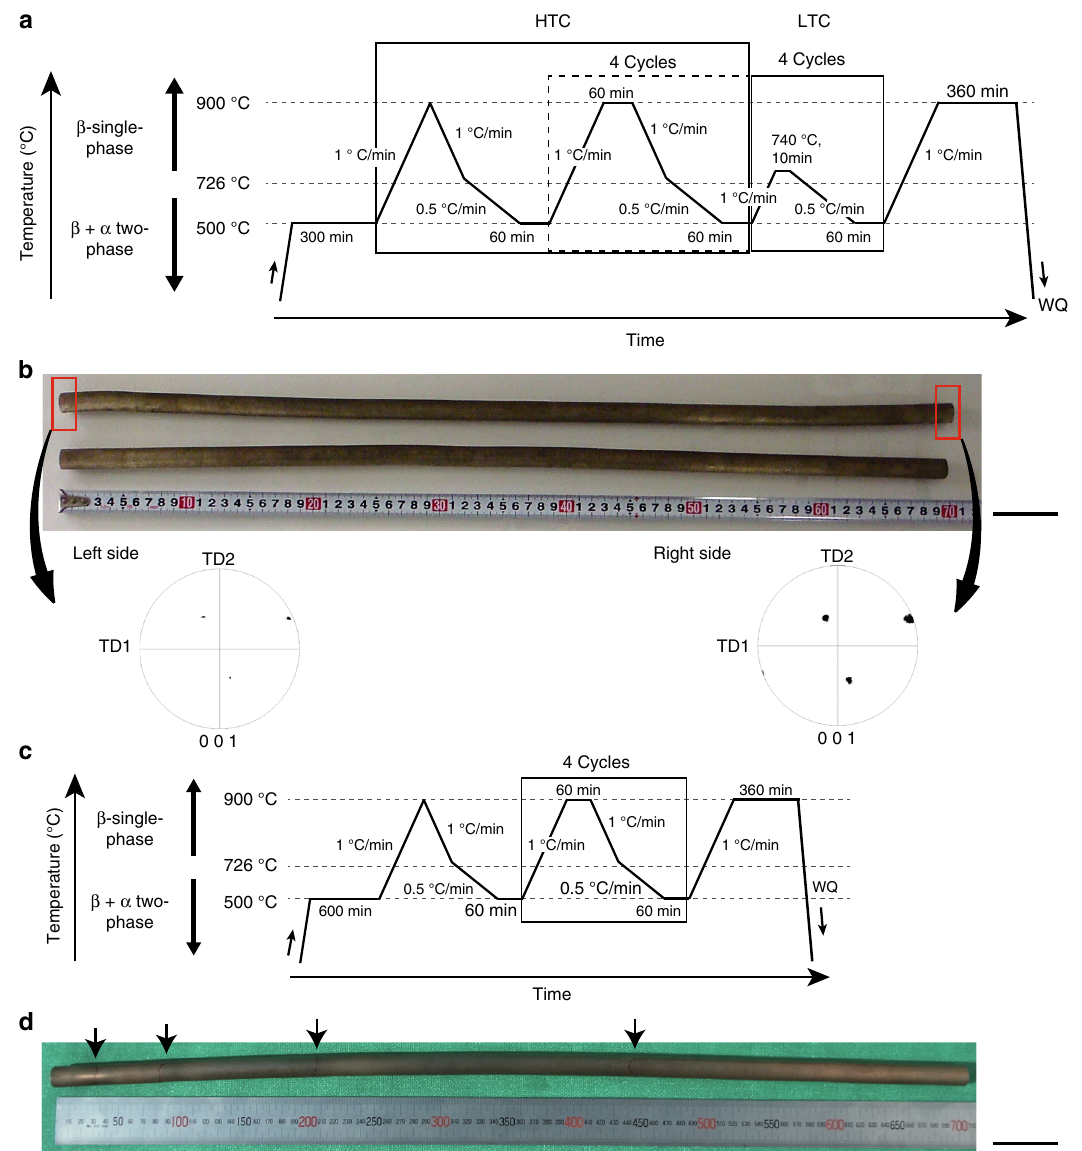
Fig. 1 Single crystal and oligocrystalline Cu-Al-Mn shape memory alloy bars. a Diagram of cyclic heat treatment (CHT) with a combination of the high-temperature cycle (HTC) and low-temperature cycle (LTC) for obtaining a single crystal (WQ: water quenching). b Cu-Al-Mn single crystal bars 15 mm in diameter and 700 mm in length obtained by the CHT shown in Fig. 1a, and (001) pole fi gures at the both ends of the bar, which show that the crystal orientations at the both ends are almost the same. Scale bar , 50 mm. c Diagram of HTC without LTC. d Cu-Al-Mn alloy bar with a bamboo structure 15 mm in diameter and 700 mm in length, subjected to CHT shown in Fig. 1c. The maximum length of a crystallographic grain is about 250mm and some grain boundaries, as indicated by arrows, are always detected in the bar specimens after this treatment. Scale bar , 50